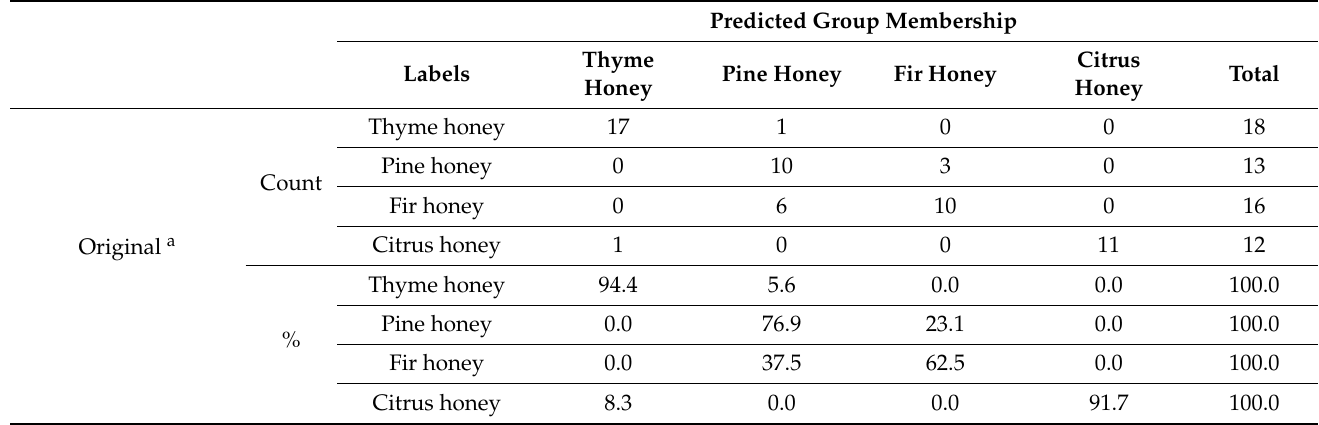
Table 4. Discrimination results based on fluorescence at λ ex = 360 nm.